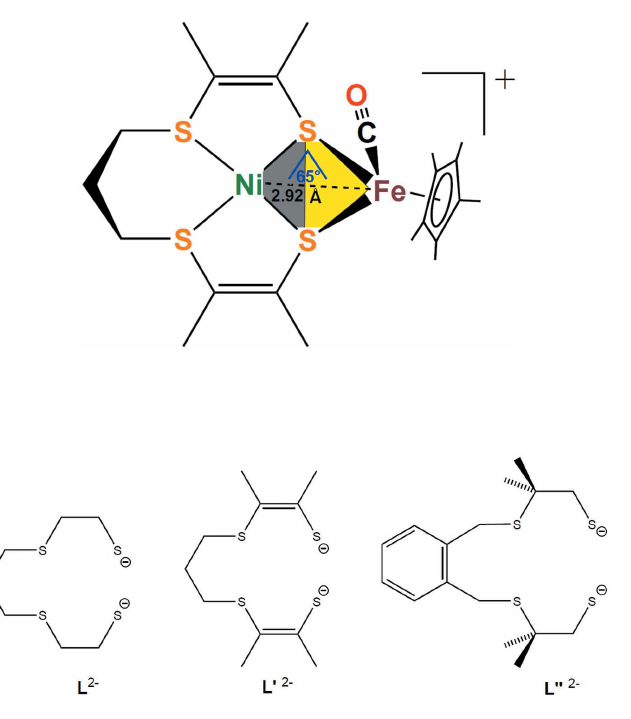
Figure 2 ‘S 4 ’ ligands used for the structurally characterized NiFe hydrogenase models of the type [Ni(‘S 4 ’)Fe(Cp R )(CO)] + .